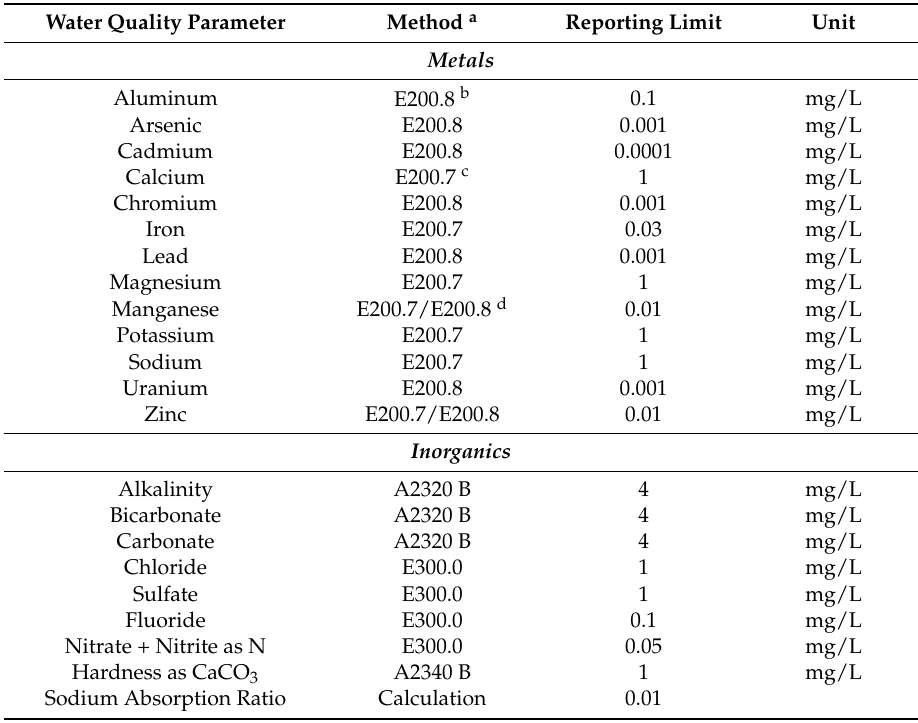
Table 1. Well water parameters tested, methods used and reporting limits. For the Lab’s EPA and other certifications, as well as their quality control manual, see their website